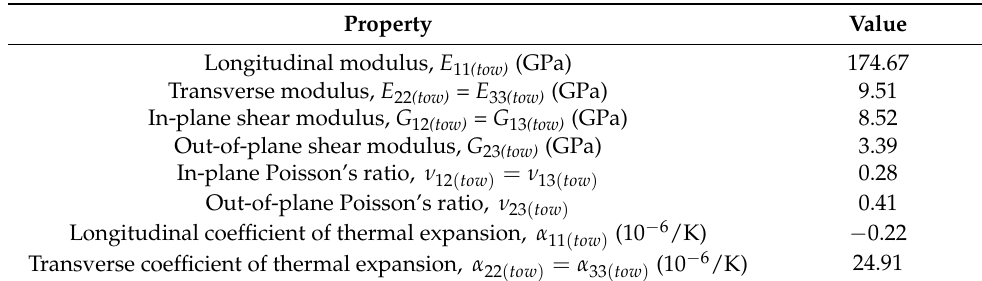
Table 8. Mechanical properties of the fiber tows in the meso-scale RUC of the T300/Cycom970 plain-woven